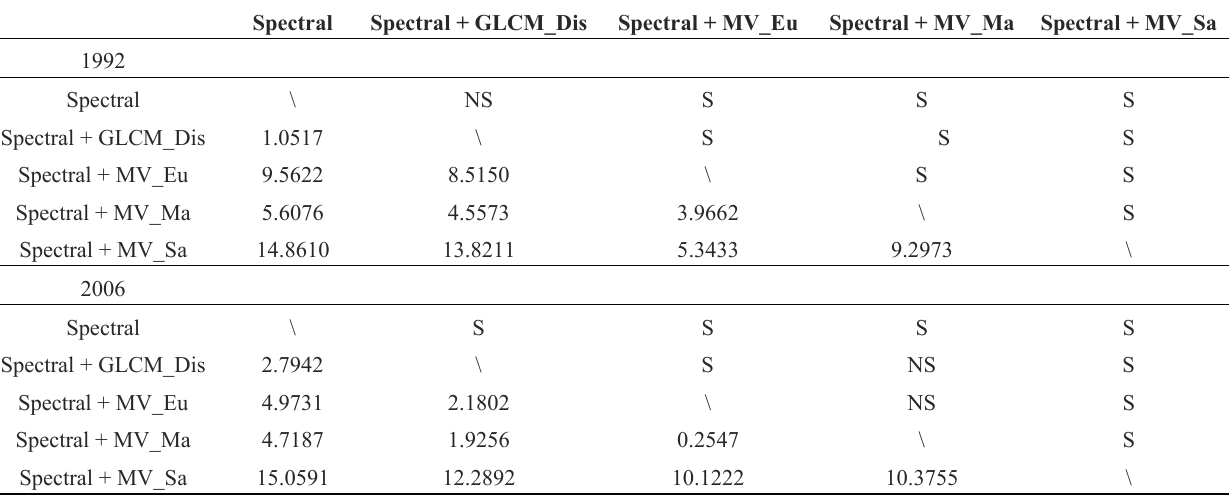
Table 7. The |(cid:1852)| values from McNemar’s test for the comparison of kappa coefficients from different classification results of the Tianjin images and corresponding statistical significances (at the 95% confidence level).